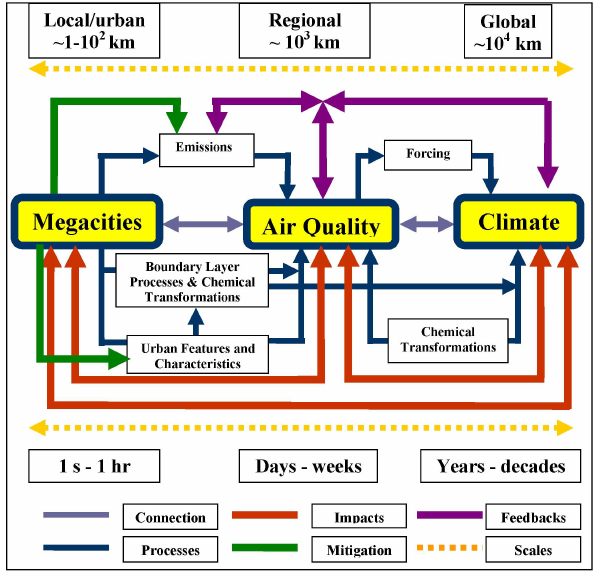
Figure 2. Schematic showing the main linkages between megac- ities, air quality and climate. The connections and processes will be the focus of MEGAPOLI. In addition to the overall connections between megacities, air quality and climate, the figure shows the main feedbacks, ecosystem, health and weather impact pathways, and mitigation routes which will be investigated. The relevant tem- poral and spatial scales are additionally included.